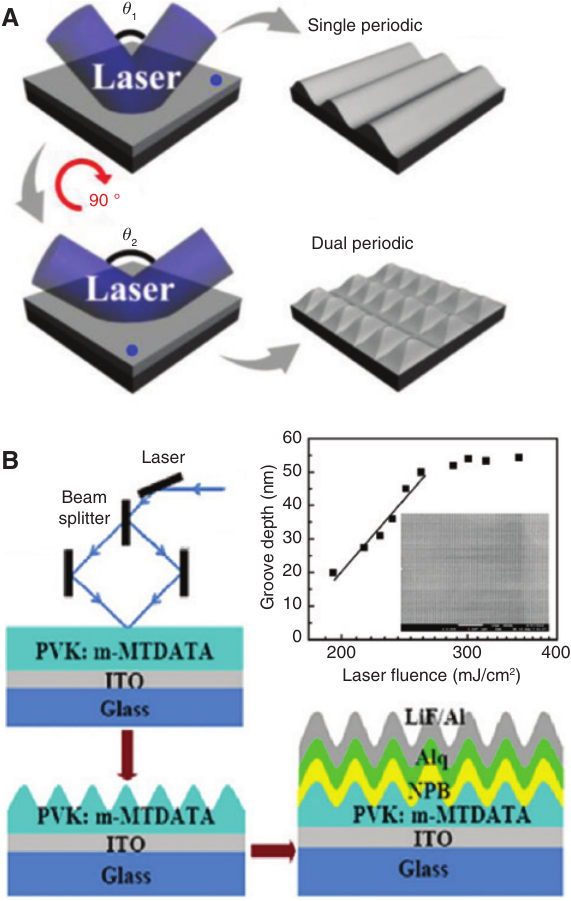
Figure 2: Two-beam interference lithography technique.